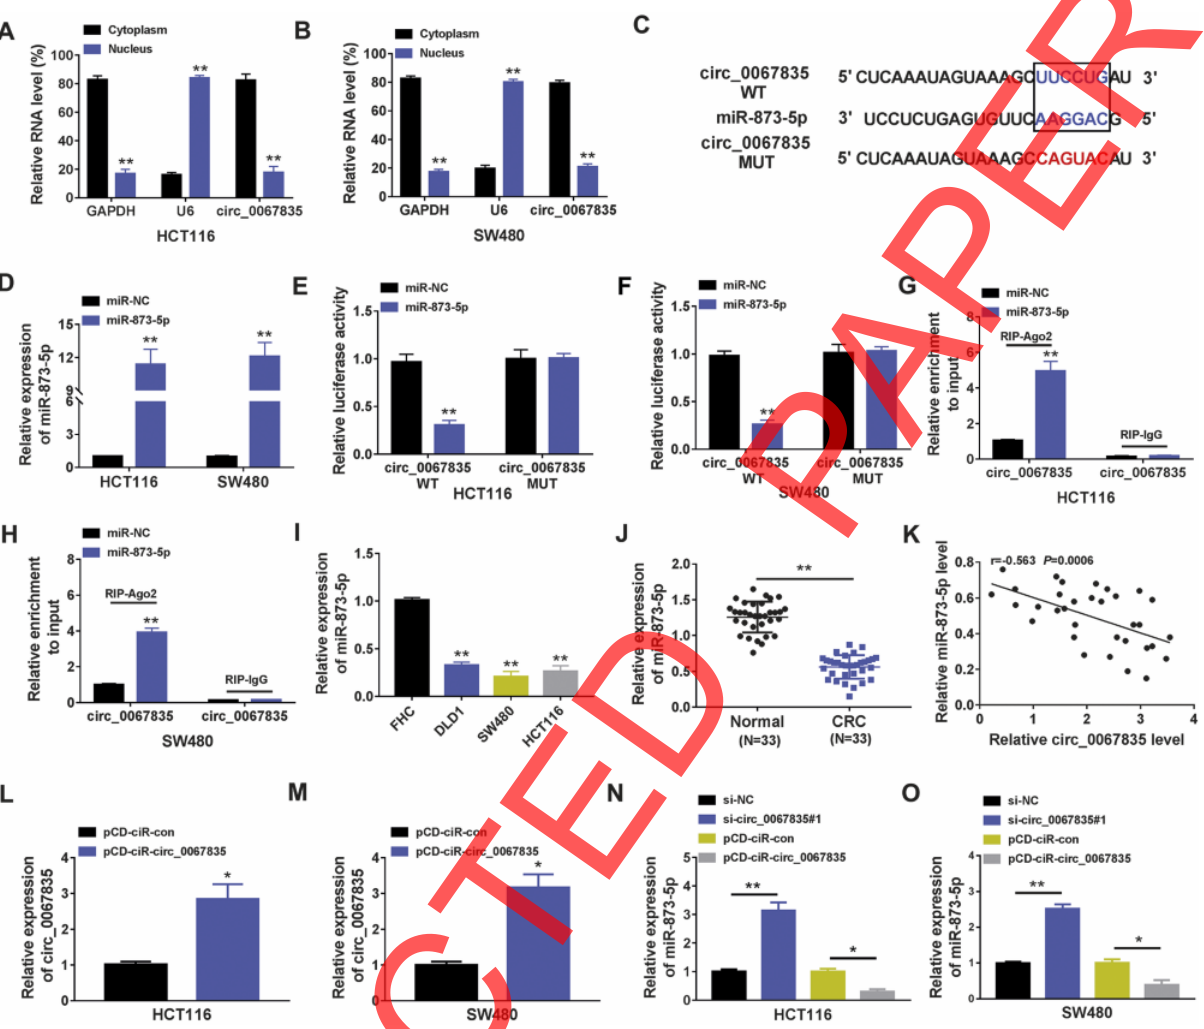
Fig. 3 Circ_0067835 acted as a sponge of miR-873-5p. (A-B) Subcellular fractionation assay for the location of circ_0067835 in HCT116 and SW480 cells. (C) Binding sites between circ_0067835 and miR-873-5p predicted by Circular RNA Interactome. (D) qRT- PCR assay for the relative expression of miR-873-5p in HCT116 and SW480 cells transfected with miR-NC or miR-873-5p. (E-F) Dual- luciferase reporter assay for the luciferase activity of HCT116 and SW480 cells co-transfected with circ_0067835 WT or circ_0067835 MUT and miR-NC or miR-873-5p. (G-H) RIP assay and qRT-PCR assay for the binding potency between circ_0067835 and miR-873- 5p. (I) qRT-PCR assay for the relative expression of miR-873-5p in FHC, DLD1, SW480 and HCT116 cells. (J) qRT-PCR assay for the relative expression of miR-873-5p in normal tissues and CRC tissues (n = 33). (K) Pearson correlation analysis for the correlation between the expression of circ_0067835 and miR-873-5p in CRC tissues. (L-M) qRT-PCR assay for the relative expression of circ_0067835 in HCT116 and SW480 cells transfected with pCD-ciR-con or pCD-ciR-circ_0067835. (N-O) qRT-PCR assay for the relative expression of miR-873-5p in HCT116 and SW480 cells transfected with si-NC, si-circ_0067835#1, pCD-ciR-con or pCD-ciR-circ_0067835. * p < 0.05, ** p <